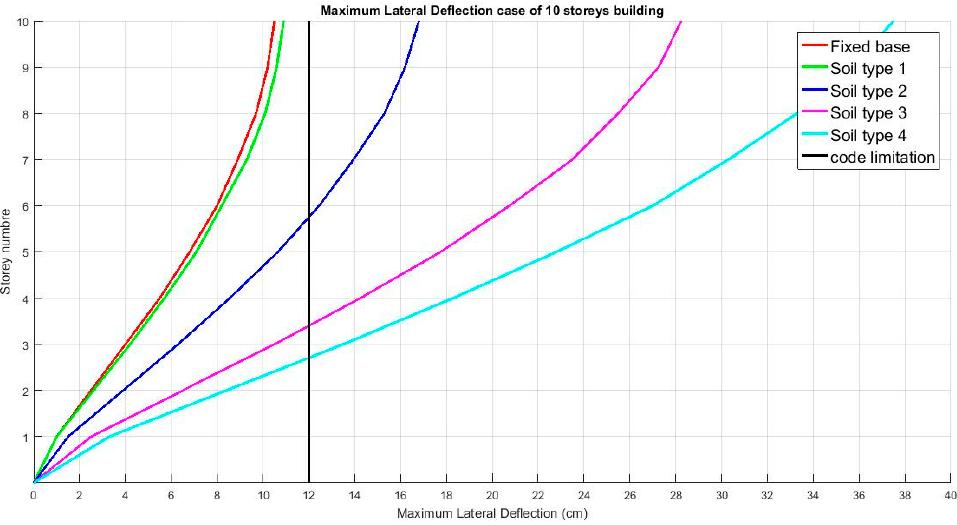
Figure 7. Maximum lateral deflection case of a 10-story building.